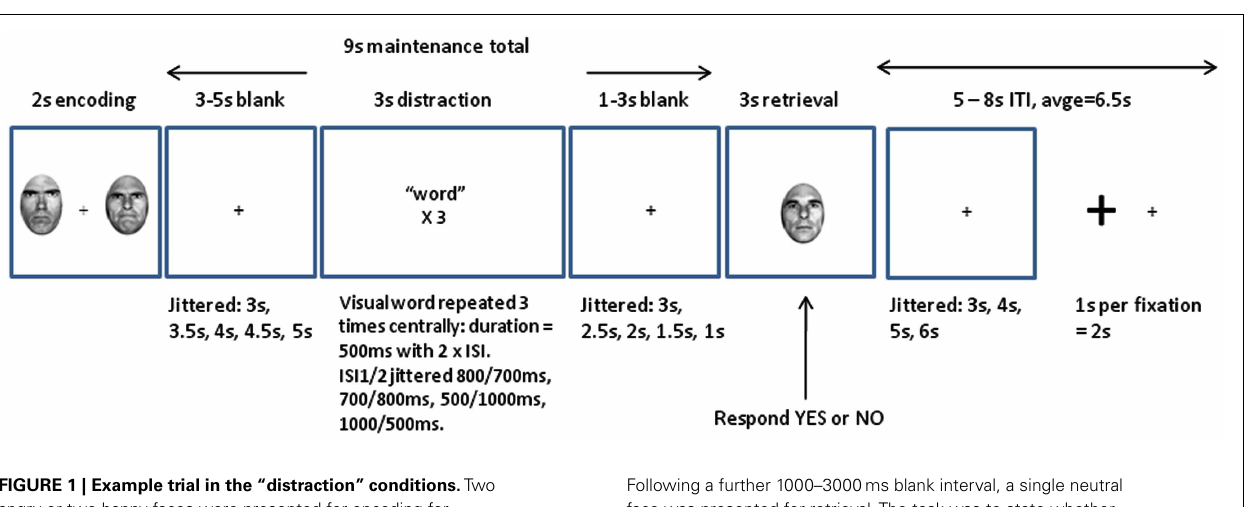
Following a further 1000–3000ms blank interval, a single neutral face was presented for retrieval.The task was to state whether the single neutral face shared identity with one of the faces present at